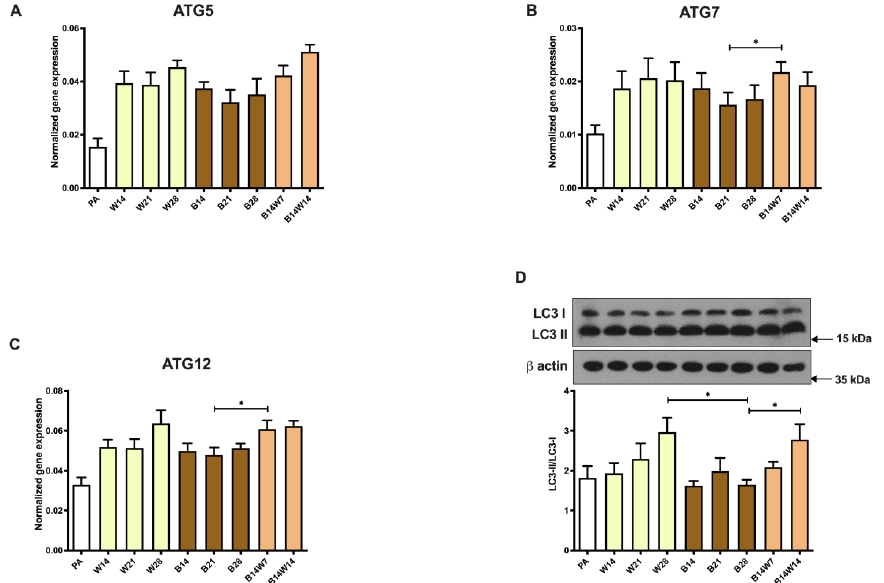
Figure 4. General autophagy markers showed a decreasing trend following long-term rosiglitazone treatment and were increased upon beige (B) to white (W) transition. Human primary abdominal subcutaneous preadipocytes were differentiated as in Figures 1–3. ( A – C ) Quantification of ATG5 , ATG7 , and ATG12 gene expression; ( D ) representative immunoblot and densitometry analysis of LC3-II/LC3-I protein ratio. Gene expressions were normalized to GAPDH . Data are presented as mean ± SD. n = 6. * p < 0.05. We used one-way ANOVA with Tukey’s post hoc test. To assess the ongoing autophagy, we examined the specific autophagy marker, the conversion of LC3-I to LC3-II, in adipocytes that were fully differentiated to white or beige or underwent transition. Quantification of this process by immunoblotting is a widely accepted method to monitor autophagy rate [53]. We found a continuous elevation of the LC3-II/LC3-I ratio in white adipocytes differentiated up to 28 days, which indicated high autophagy activity. In beige adipocytes, the activity remained at a moderate level, signif- icantly lower than with the white cells, after four weeks of differentiation. When the beige protocol was replaced by white, the autophagy level was significantly increased after two weeks, as compared to the fully differentiated beige adipocytes (Figure 4D). This was con- firmed when the subcellular distribution of LC3 was visualized by immunostaining (Fig- ure 5A; see secondary antibody control in Figure S1). As expected, white adipocytes, which were differentiated after three or four weeks, contained more LC3 punctae per cell than